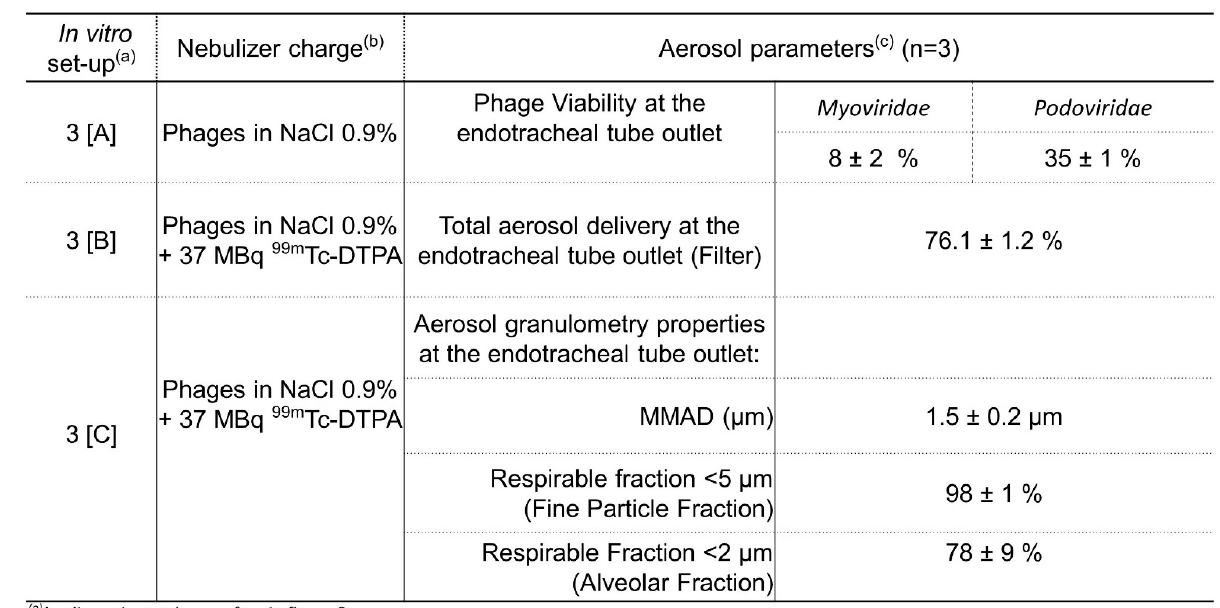
Figure 7. Aerodynamic properties of phage aerosol produced by the static-mesh prototype nebulizer and delivered during adult human mechanical ventilation.